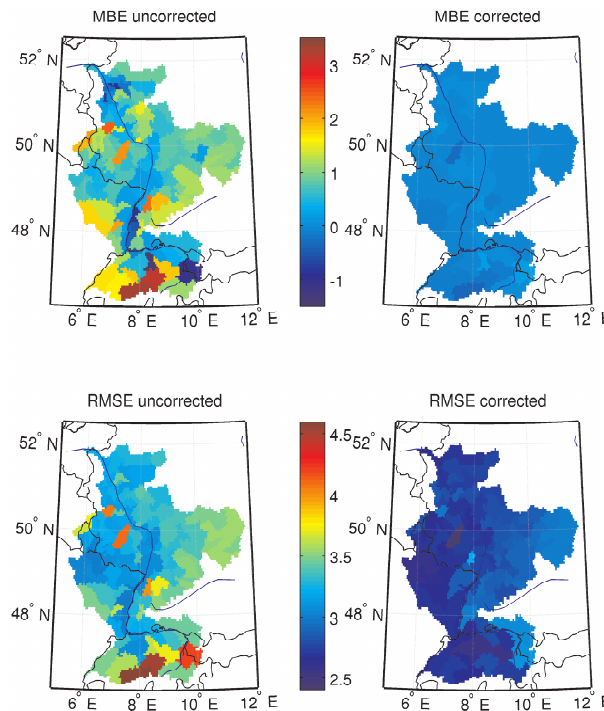
Fig. 9. Top: MBE for the uncorrected and corrected ERA15/REMO temperature [ ◦ C] per sub-basin for the period 1979–1995. Bot- tom: RMSE for the uncorrected and corrected ERA15/REMO tem- perature [ ◦ C] per sub-basin for the period 1979–1995.